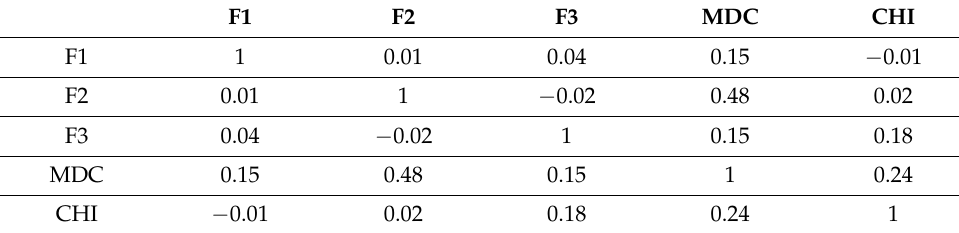
Table 1. Predictor variables correlation matrix (Spearman’s correlation coefficient).